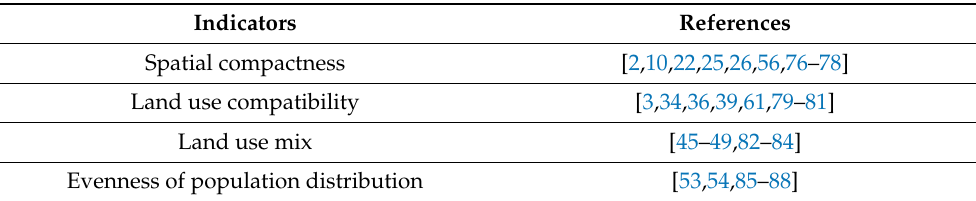
Table 3. Indicators of social benefit measure in land use